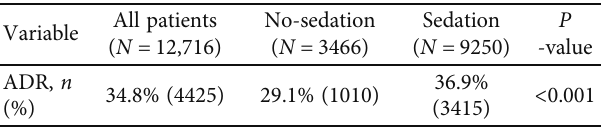
Table 2: Outcome comparison between sedation and no-sedation groups.